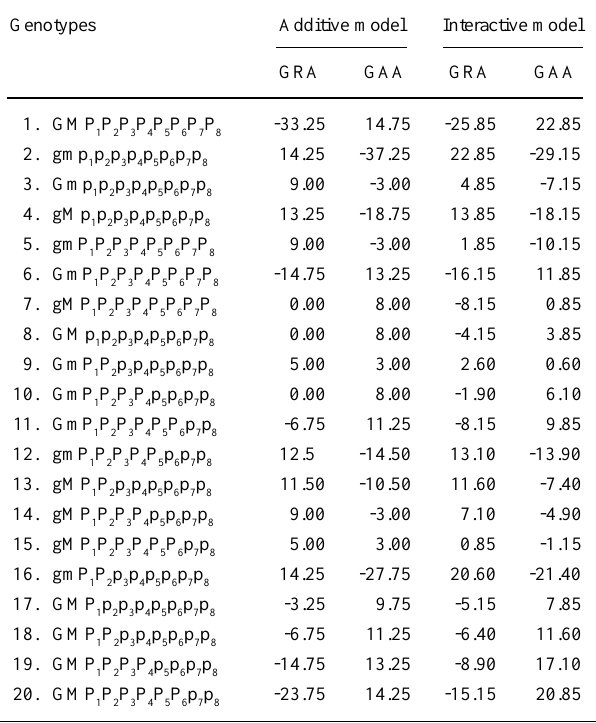
Table VIII - Estimates of general reaction ability (GRA) and aggressivity (GAA) according to additive and interactive models from 20 x 20 diallel.